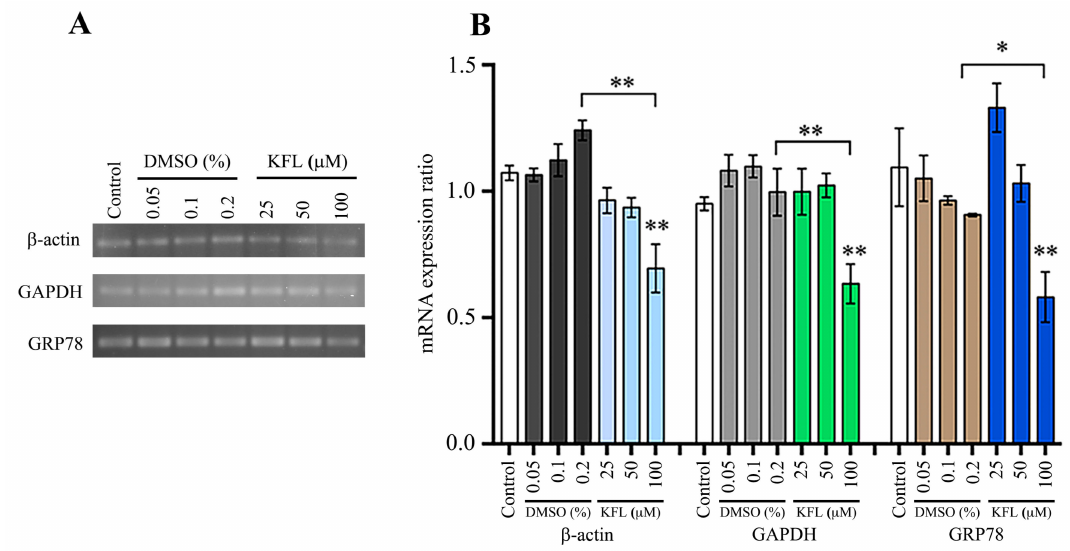
Figure 8. E ff ect of kaempferol treatment on gene transcription in BHK-21 cells. BHK-21 cells were treated with di ff erent concentrations of kaempferol or DMSO vehicle control for 24 h after which expression of β -actin, GAPDH and GRP78 was determined by semi-quantitative PCR ( A ). The band intensity was quantitated using ImageJ analysis software and analysed by GraphPad Prism7 program. The relative expression level of all transcripts was quantitated against the average value and the analysis is presented as bar graph ( B ). Experiment was undertaken independently in triplicate and data was normalized against the average signal for all conditions. Error bars represent SD, *; p value ≤ 0.05, **; p value ≤ 0.01. All statistics were evaluated by comparing between the treated samples and the equivalent DMSO